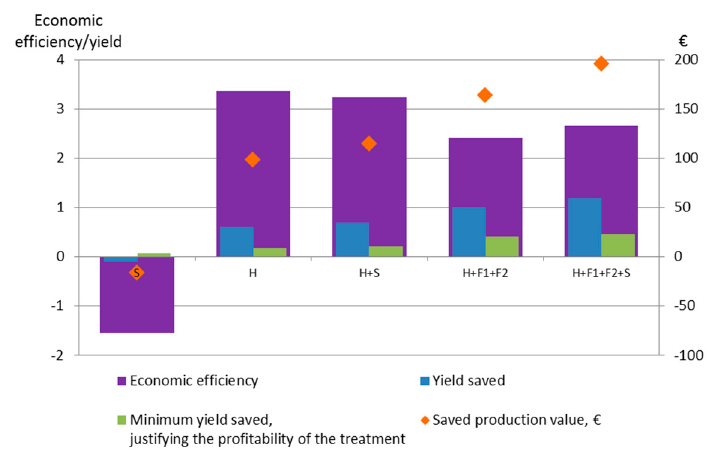
Figure 5. Economic efficiency, yield saved, minimum yield justifying the profitability of the treatment, and saved production value between diverse protection strategies. Figure shows average values from four seasons.